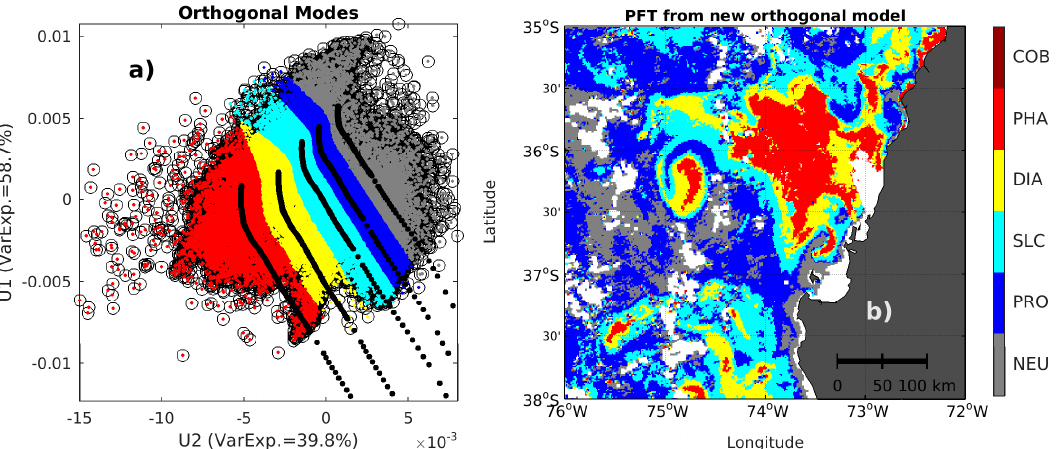
Figure 8. ( a ) The dimensionless U 1 –U 2 plane derived from the joint SVD of the synthetic matrix Rs and an R matrix composed by the average MODIS-A nLw data during 4–6 February 2014. The colors represent the respective PFTs assigned to each dot (pixel) considering their closeness to the unadjusted PFT orthomodels (black dots) obtained from the acceptable ranges proposed by PHYSAT. ( b ) The unadjusted PFT estimation of PHYSTWO by rearranging the assignments of ( a ) in a longitude–latitude plane. Abbreviations are the same as in Figure 5.